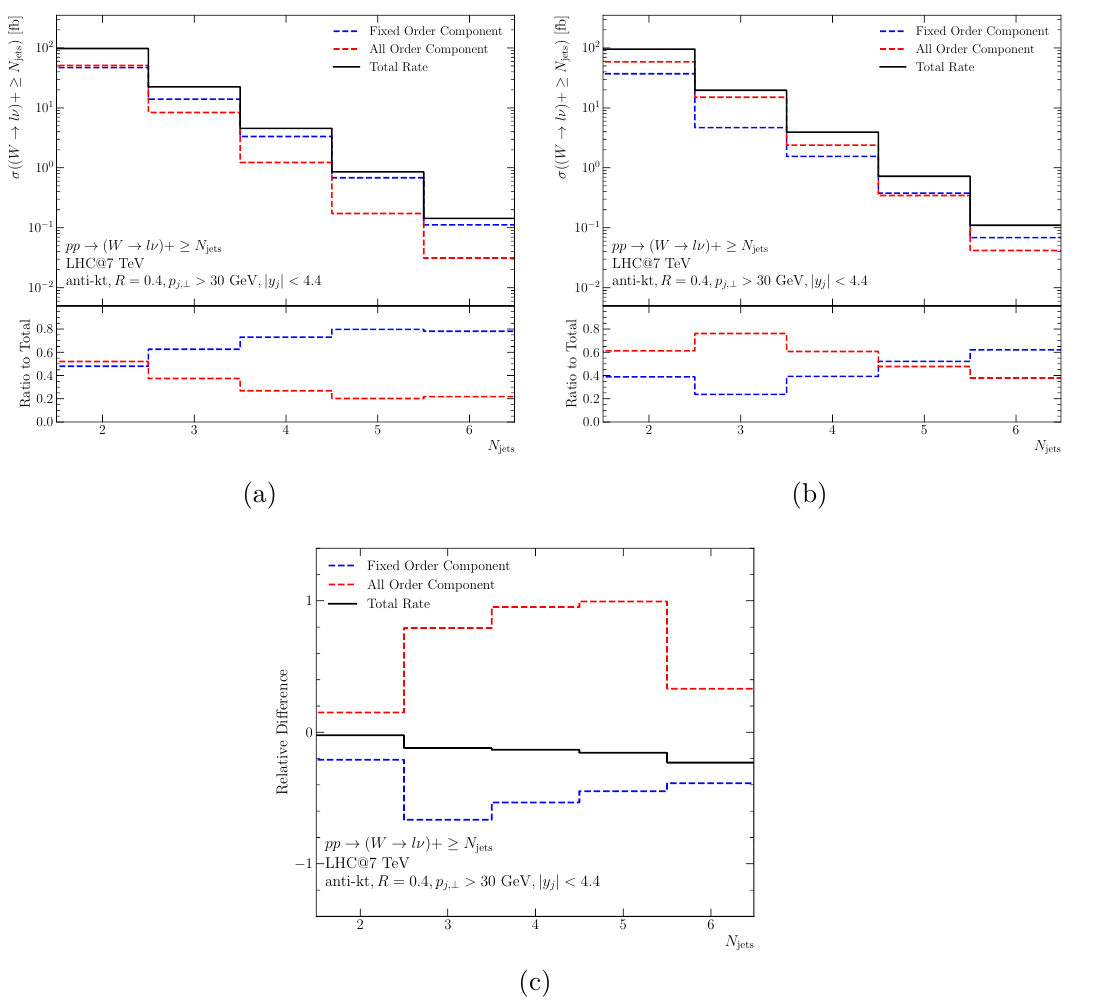
Figure 21. Inclusive N jets cross sections for pp → ( W → ‘ν )+ ≥ N jets where resummation is applied only to LL states (a) and where resummation is applied to all LL and NLL states (b). Also shown in each case is the breakdown into the component where all-order resummation is applied (red, dashed) and the component which remains described at fixed-order only (blue, dashed). Panel (c) shows the relative change in each line. Further details are given in section